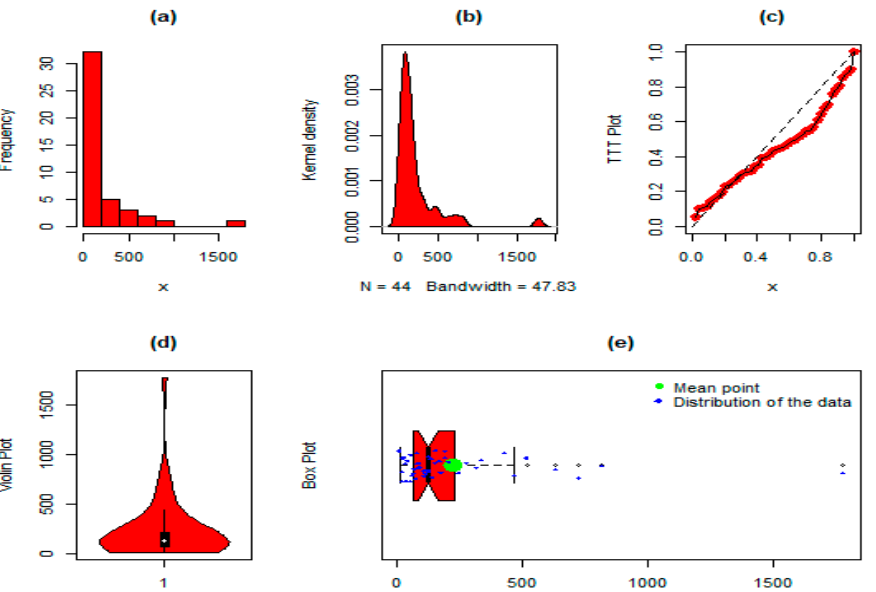
Figure 6. For dataset 2, the ( a ) histogram, ( b ) kernel density plot, ( c ) TTT plot, ( d ) violin plot, and ( e ) box plot. Table 9. The ˆ δ MLE , ˆ β MLE , ˆ α MLE , ˆ a MLE , ˆ b MLE and ˆ θ MLE for head and neck cancer data (dataset